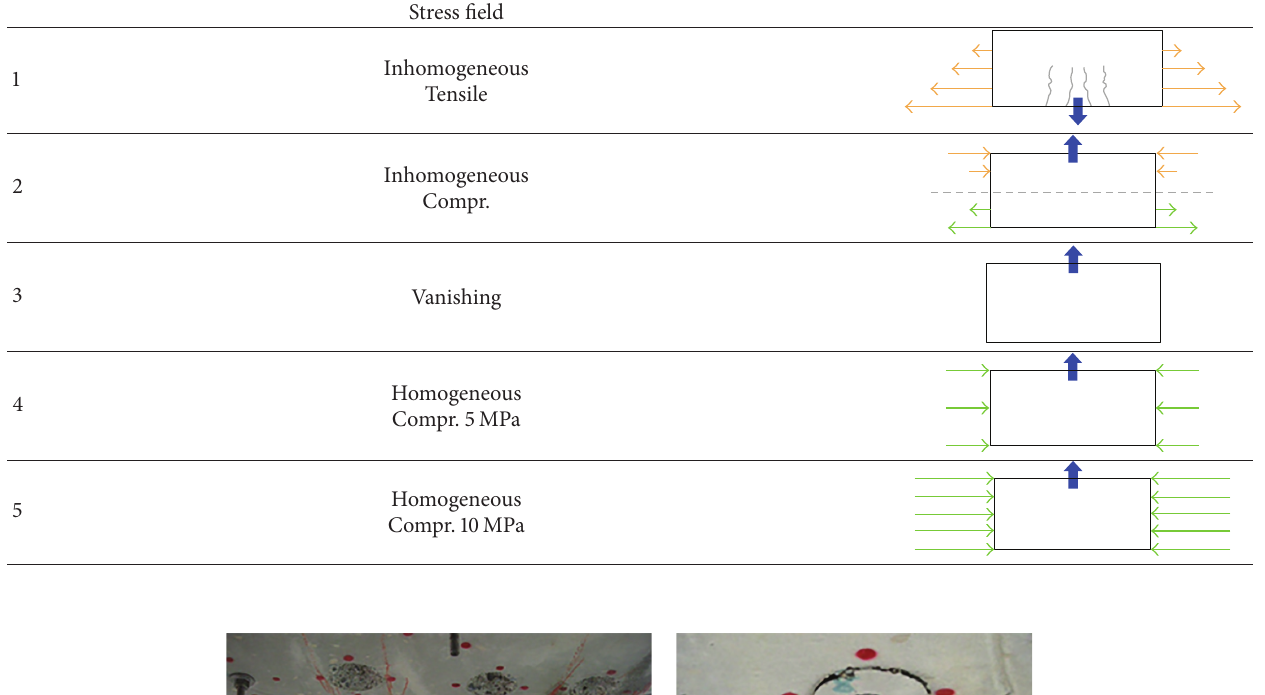
Table 2: Stress states considered in the testing campaign.